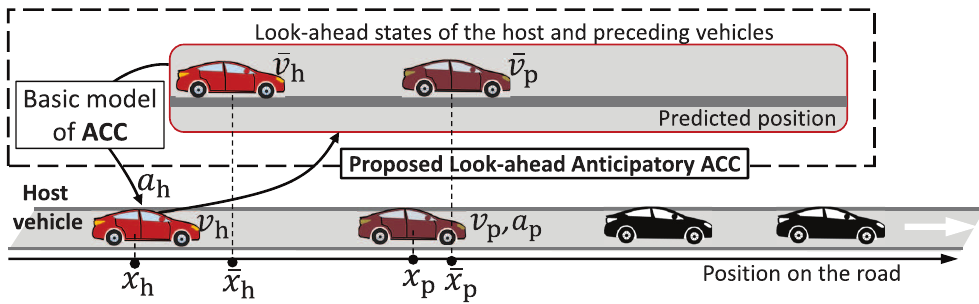
Figure 1. The decision-making process of the proposed La-ACC, where the driving decision is taken using the look-ahead or predicted states and the basic model of